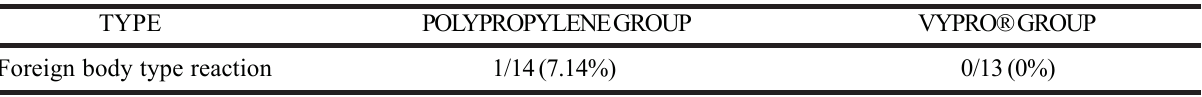
TABLE 2 - Comparison of the presence of macroscopic reaction to the polypropylene and vypro® mesh implant.